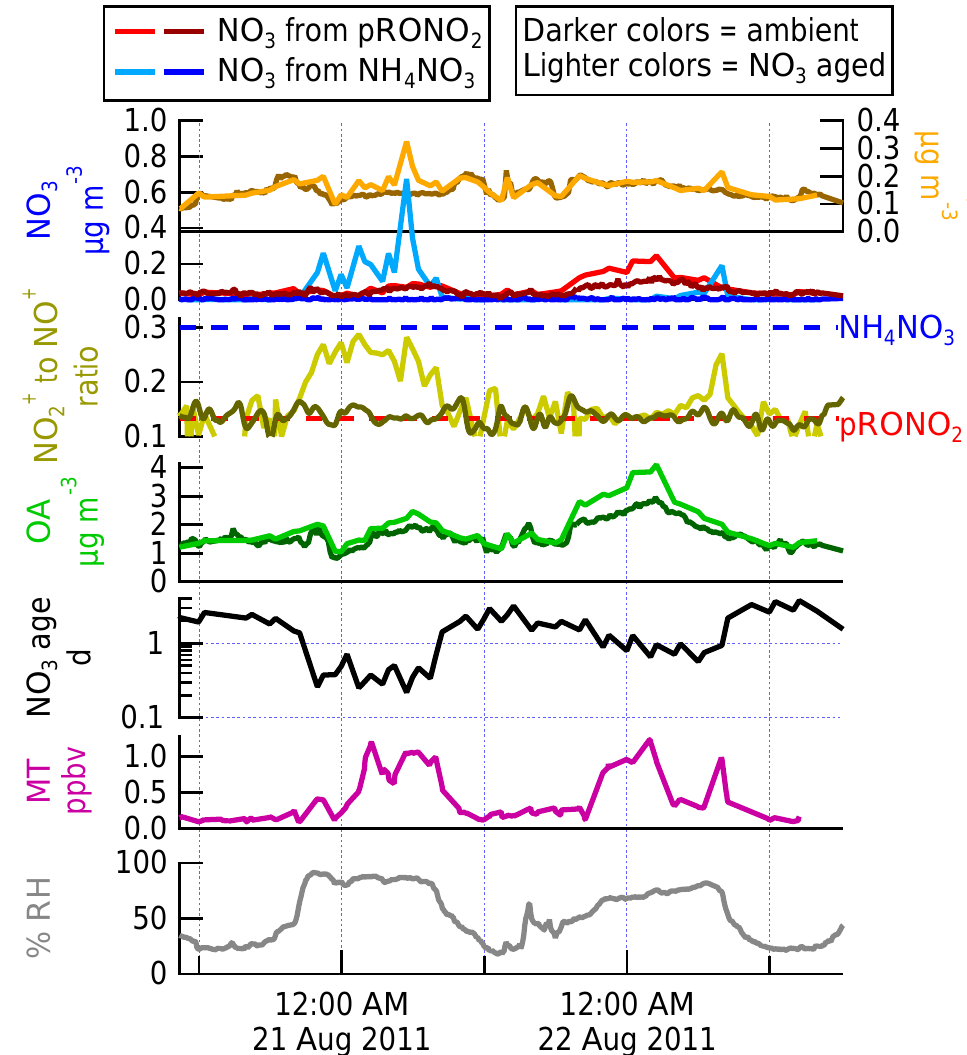
Figure 12. Example time series of OA, NH 4 , and NO 3 (split into pRONO 2 and NH 4 NO 3 ) aerosol measurements after NO 3 oxidation in the OFR, compared to ambient aerosol, NO + to NO + ratio, model-derived eq. age of NO 3 oxidation, MT concentration, and RH measurements. 2 Production of both NH 4 NO 3 and pRONO 2 was observed at different times, which appears to depend on changes in experimental